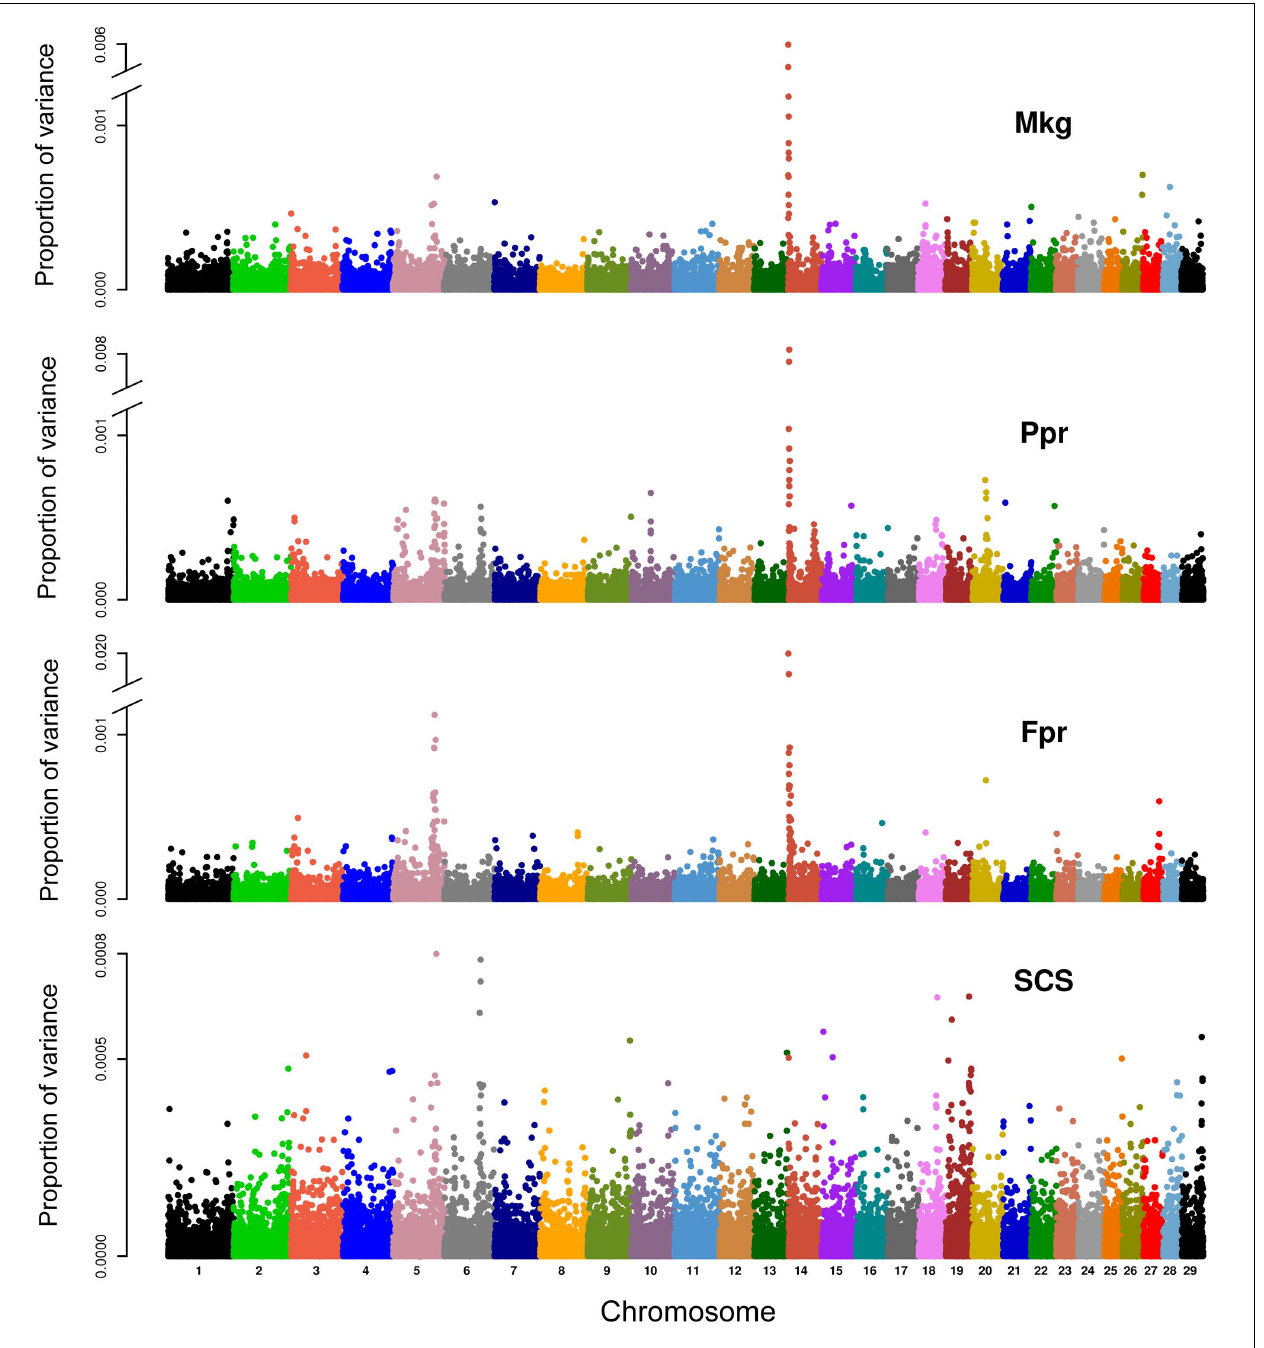
FIGURE 4 | Proportion of genetic variance for milk yield (Mkg), protein percentage (Ppr), fat percentage (Fpr), and somatic cell score (SCS) explained by each marker in the panel (estimated using method 3).